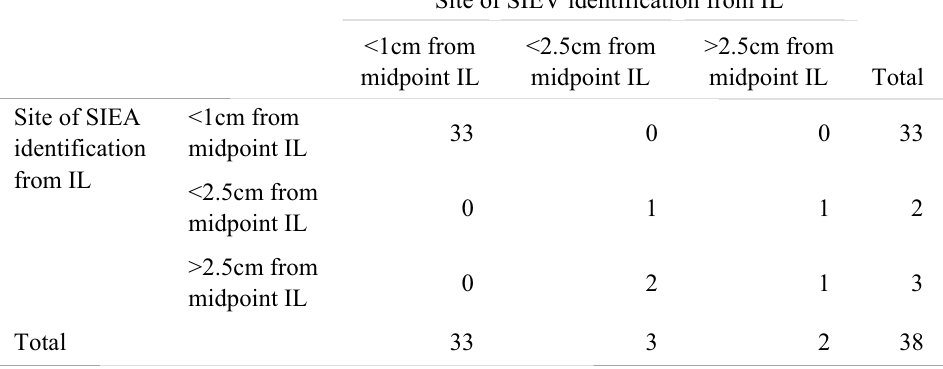
TABLE 3 - Site of identification of SIEV from inguinal ligament relation to